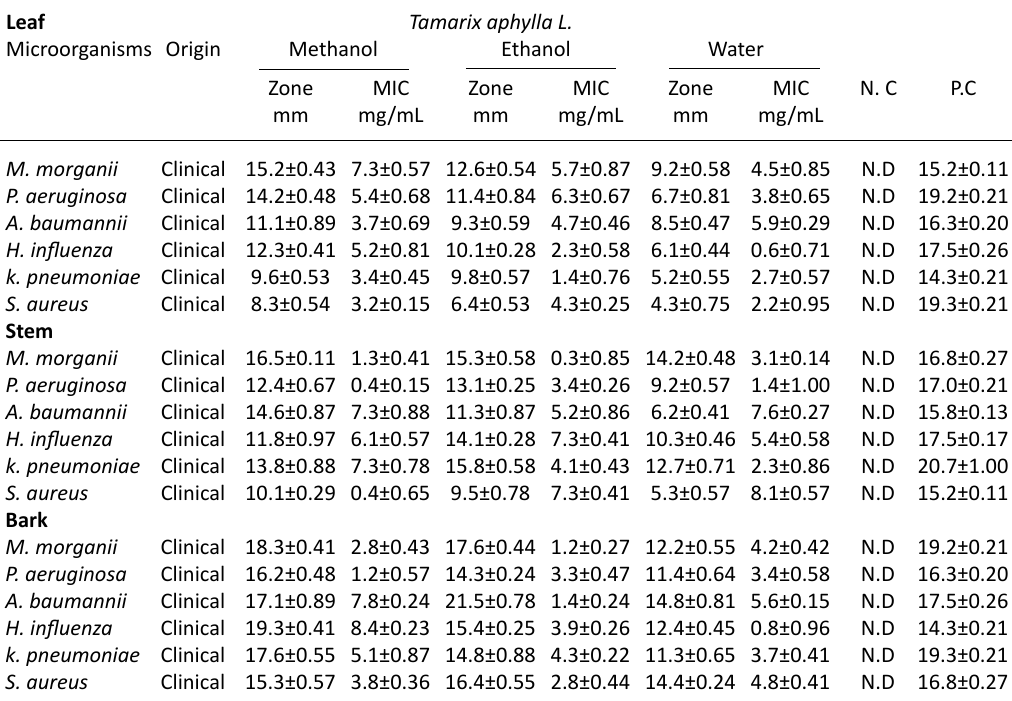
Table 2. Antibacterial activity of Tamarix aphylla L. extracts against bacterial pathogens Leaf Tamarix aphylla